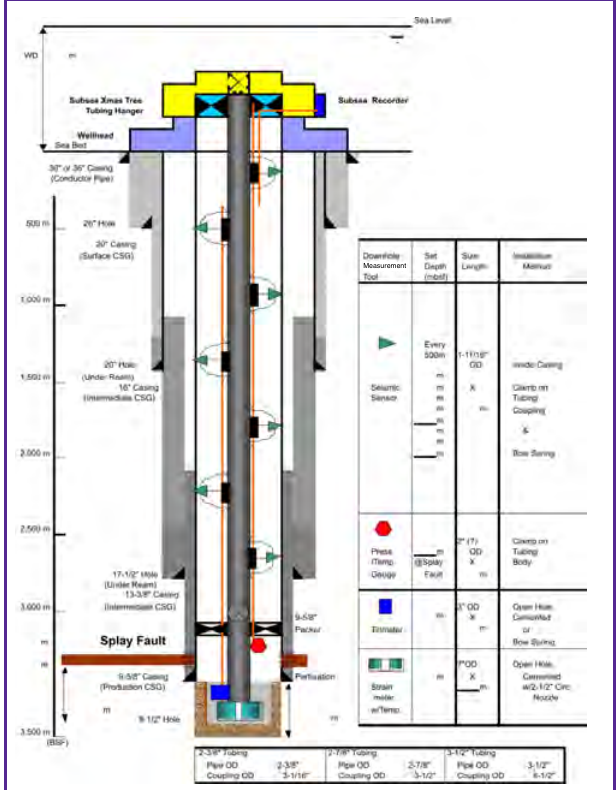
Figure 2. Schematic diagram of multi-level multi-sensor sensor configuration for